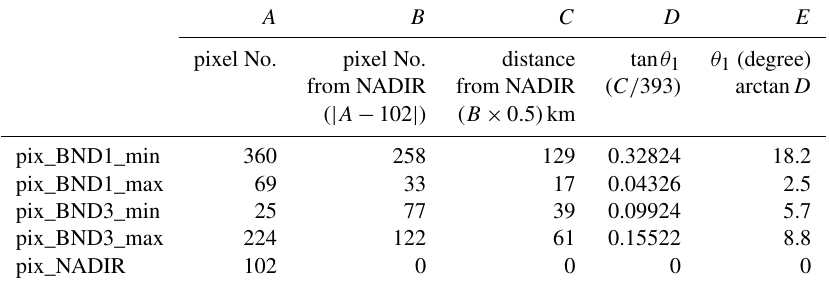
Table 2. Pixels selected for SMILE evaluation. The pixel number of the nadir is 102, θ 1 is the satellite zenith angle. A B C D E pixel No. pixel